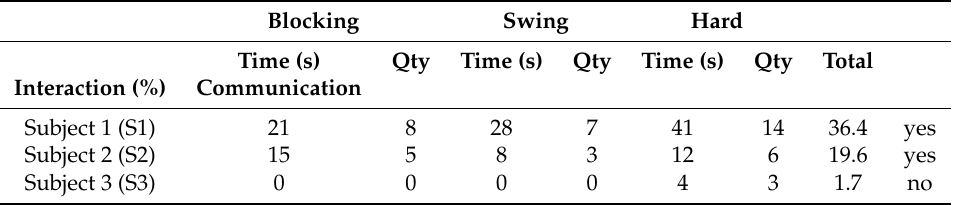
Table 3. Physical interaction during the familiarization phase. These data were generated by computing the times and the instances in which the participants made an interaction with the robot throughout the session. Quantity (Qty) denotes the number of times the event